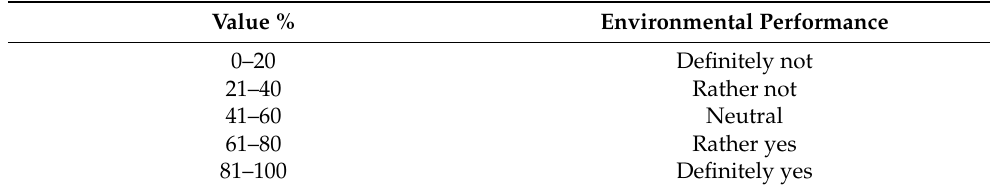
Table 6. Levels of environmental